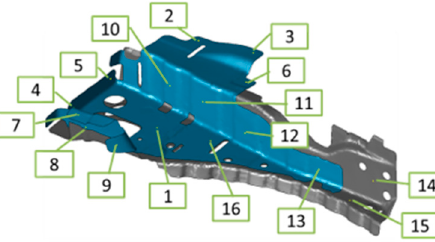
Figure 15. Measuring points.